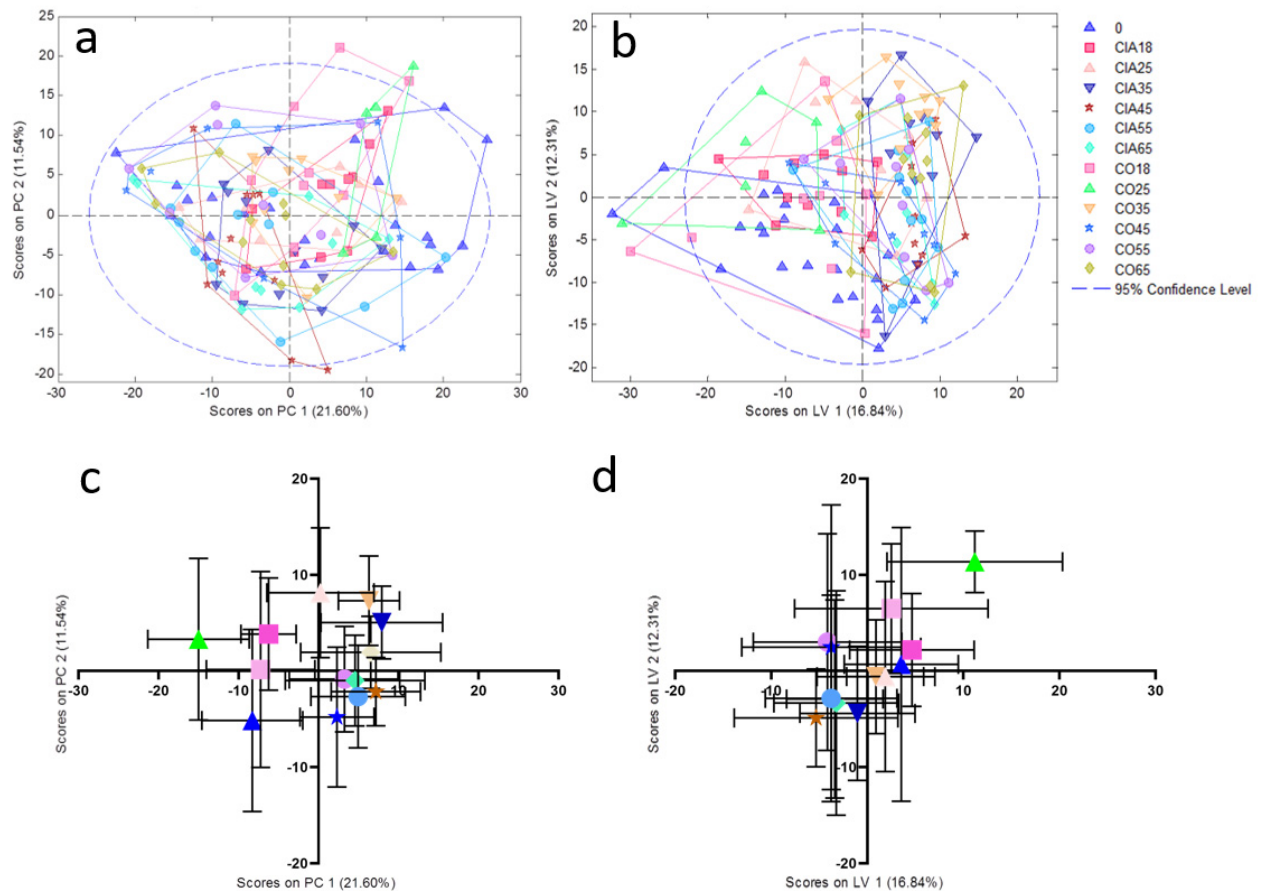
Figure 1. PCA ( a ) and PLSDA ( b ) analysis of CIA and CO groups with all-time points. ( c ) and ( d ) represent the plotted data in mean ± standard deviation of the mean from PCA and PLSDA analysis, respectively. 0: all animals before the beginning of the experiment (blue triangle); CIA18: CIA group 18 days after disease induction (pink square); CIA25: CIA group 25 days after disease induction (light pink triangle); CIA35: CIA group 35 days after disease induction (dark blue inverted triangle); CIA45: CIA group 45 days after disease induction (red star); CIA55: CIA group 55 days after disease induction (light blue circle); CIA65: CIA group 65 days after disease induction (light blue diamond); CO18: CO group 18 days after the experiment beginning of the (light pink square); CO25: CO group 25 days after the beginning of the experiment (green triangle); CO35: CO group 35 days after the beginning of the experiment (orange inverted triangle); CO45: CO group 45 days after the beginning of the experiment (blue star); CO 55: CO group 55 days after the beginning of the experiment (purple circle); CO65: CO group 65 days after the beginning of the experiment (yellow diamond). PC: principal component; LV: latent